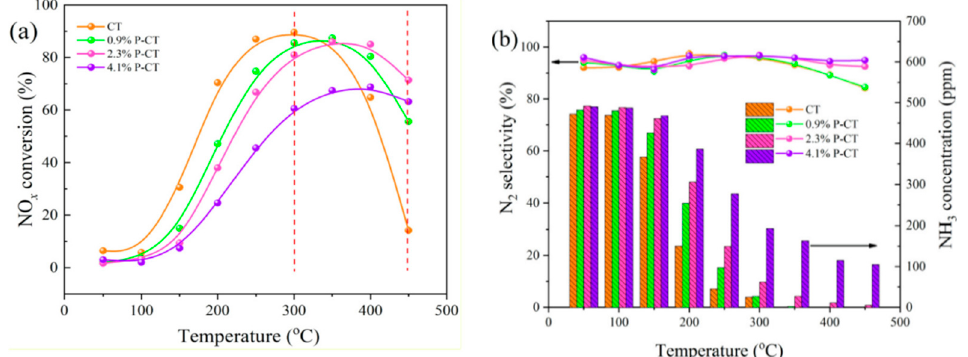
Figure 18. ( a ) NO x conversion of the CT and phosphorus-loaded catalysts, ( b ) N 2 selectivity and NH 3 concentration during the NH 3 -SCR reaction of these catalysts. Reaction conditions: [NH 3 ] = [NO] = 500 ppm, [O 2 ] = 5 vol%, N 2 as balance [84].